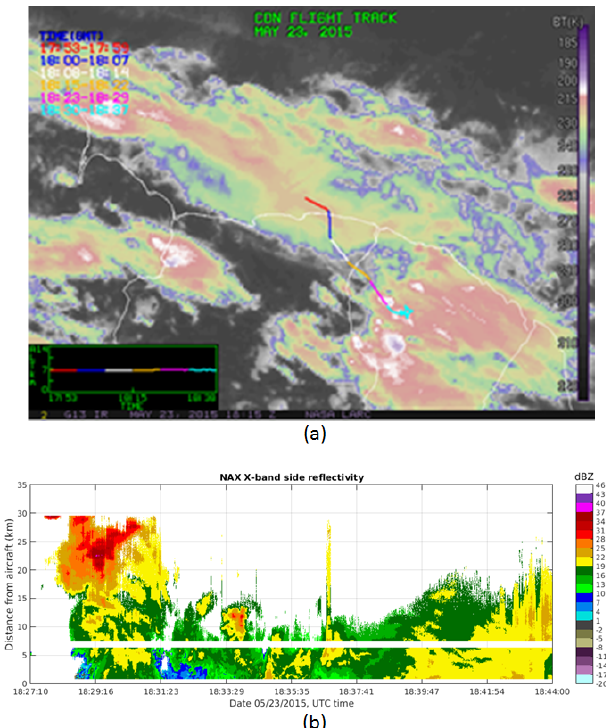
Figure 9. Similar to Fig. 4 but for the 23 May case.